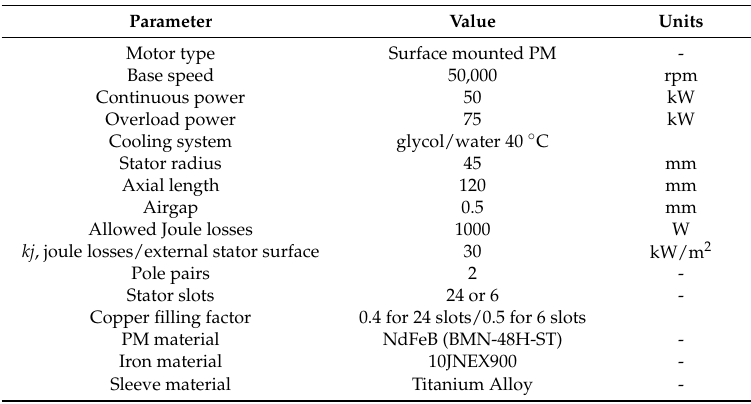
Table 1. Main machine specifications obtained after preliminary